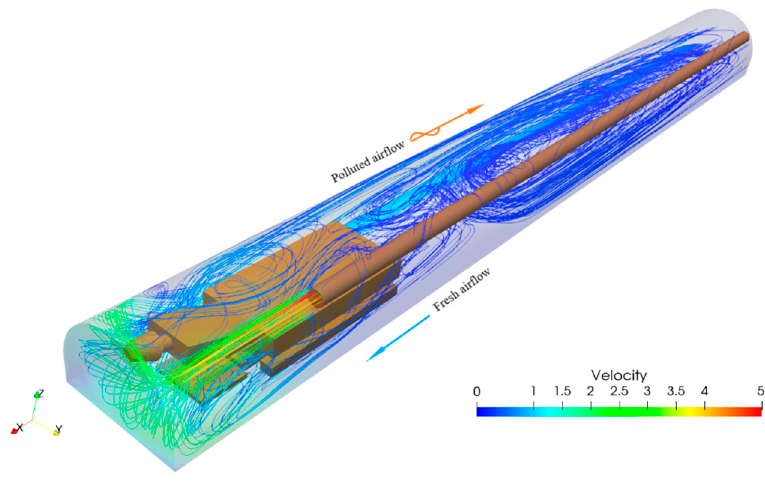
Figure 6. Streamline diagram of the airflow field in the laneway.